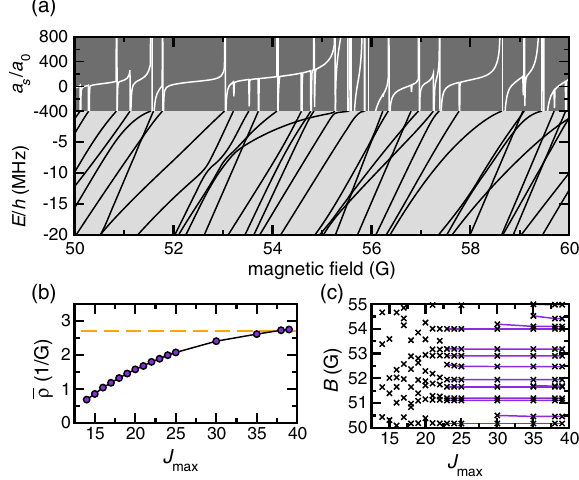
FIG. 6. Theoretical near-threshold bound states and Feshbach resonances in a magnetic field. (a) Near-threshold bound states for M ¼ − 12 168 Er 2 for fields between B ¼ 50 and 60 G (bottom half of image). The top half of the image shows the effective scattering length, defined in the text, as a function of B . It is infinite at a resonance location where a bound state has zero energy. Calculations use the physical interaction anisotropies and 39 . (b) Theoretical Feshbach- channel states with J ≤ J max ¼ resonance density ¯ ρ as a function of J (purple circles) max computed from resonance locations between 0 and 70 G. The dashed horizontal line indicates the experimental density for 168 Er 2 . (c) Convergence study of resonance locations (crosses) between 50 and 55 G as a function of J . Purple lines connect max resonances when their location has